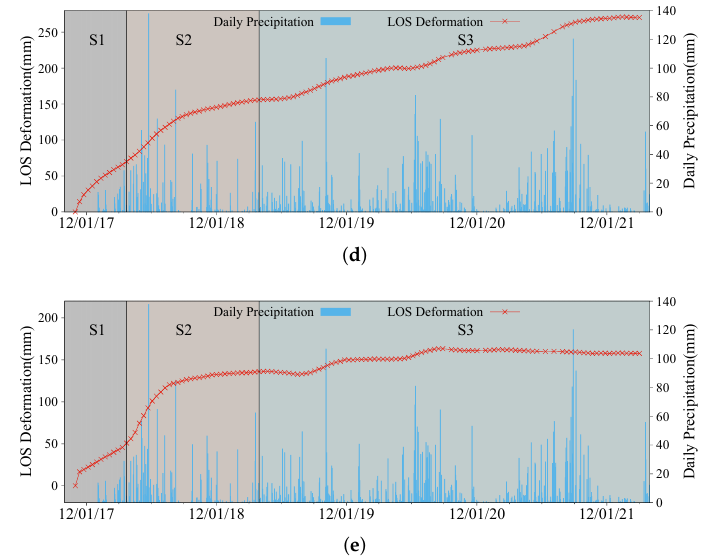
Figure 7. Time-series of the post-event displacement and rainfall for selected MPs from the five active deformation zones: ( a ) point 1, ( b ) point 2, ( c ) point 3, ( d ) point 4, ( e ), and point 5, from the cumulative displacement map (Figure 6). The three landslide movement stages S1, S2, and S3 in Figure 8 are highlighted by three-color backgrounds in the time-series plot.